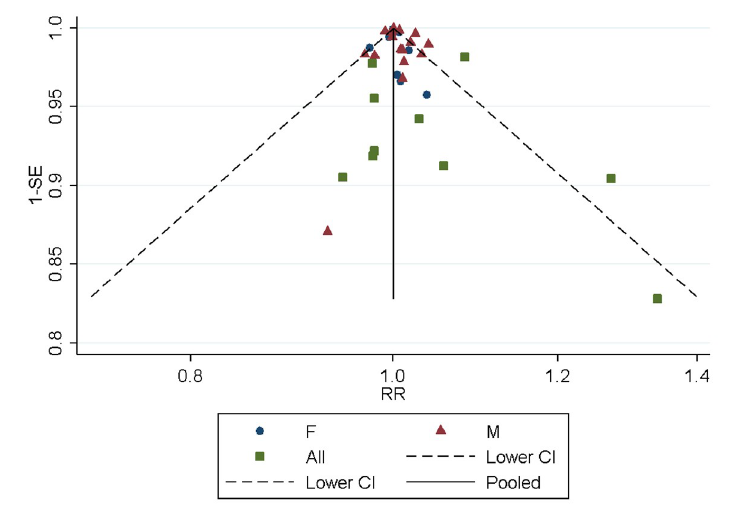
Fig 4. Funnel plot for included studies, RR against 1 –standard error.